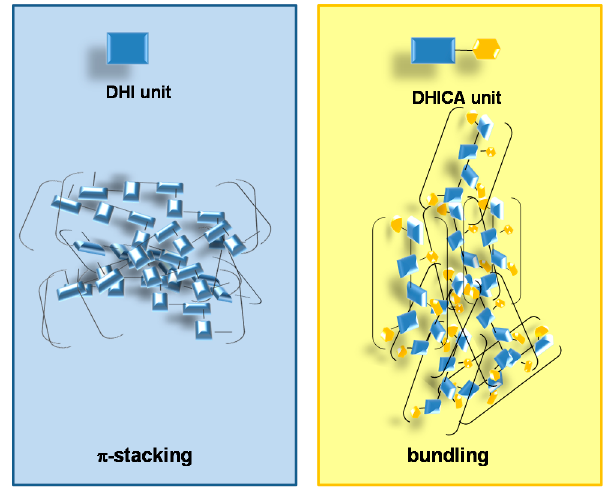
Figure 6. Simplified representation of aggregates’ formation for DHI and DHICA melanins.